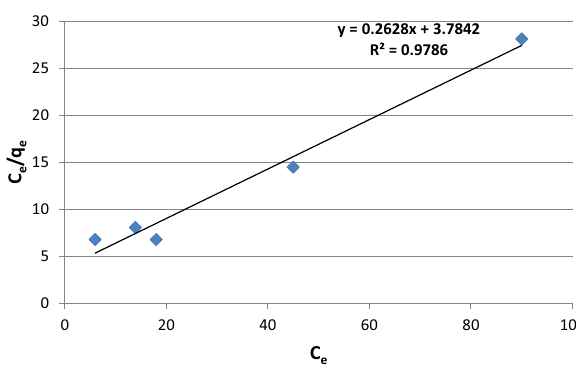
Fig. 13 ln( q C e ) versus ln( e ) for Freundlich isotherm application Table 4 Constants of Freundlich isotherm for the adsorption of CR dye by Aspergillus